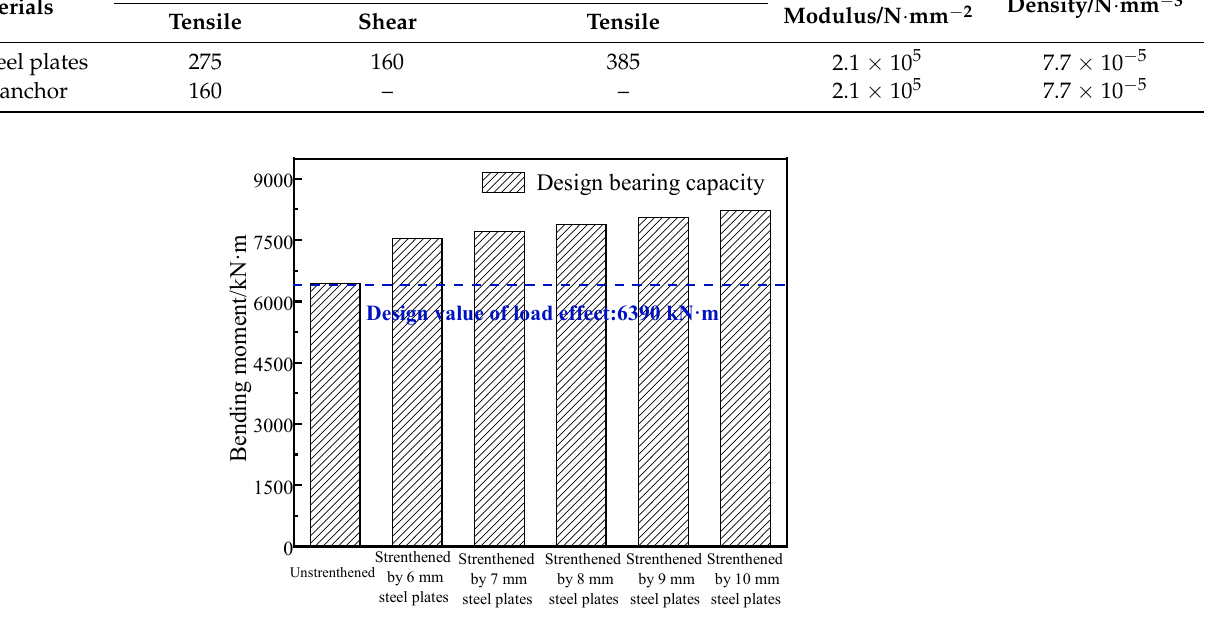
Figure 8. Comparison of the bearing capacities of the #3-2 girder strengthened by various steel plates.